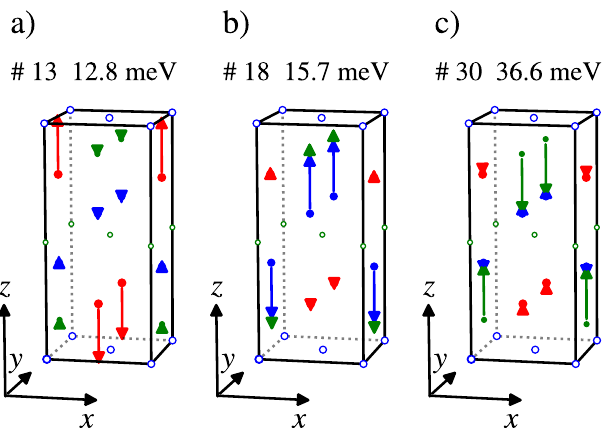
Figure 3. The atomic displacement of atoms for the Ŵ + 1 (A 1 g ) phonon mode symmetry. Calculated at 12 for CePd 2 Al 2 . For clarity the displacement of each atom is 4 times enlarged. The labels #13 #18 #30 correspond to the notation used in Supplementary information, which labels the modes for a given q with increasing energy. The red, blue and green colours correspond to Ce, Pd and Al ions, respectively. The open circles represents static atoms in the mode.